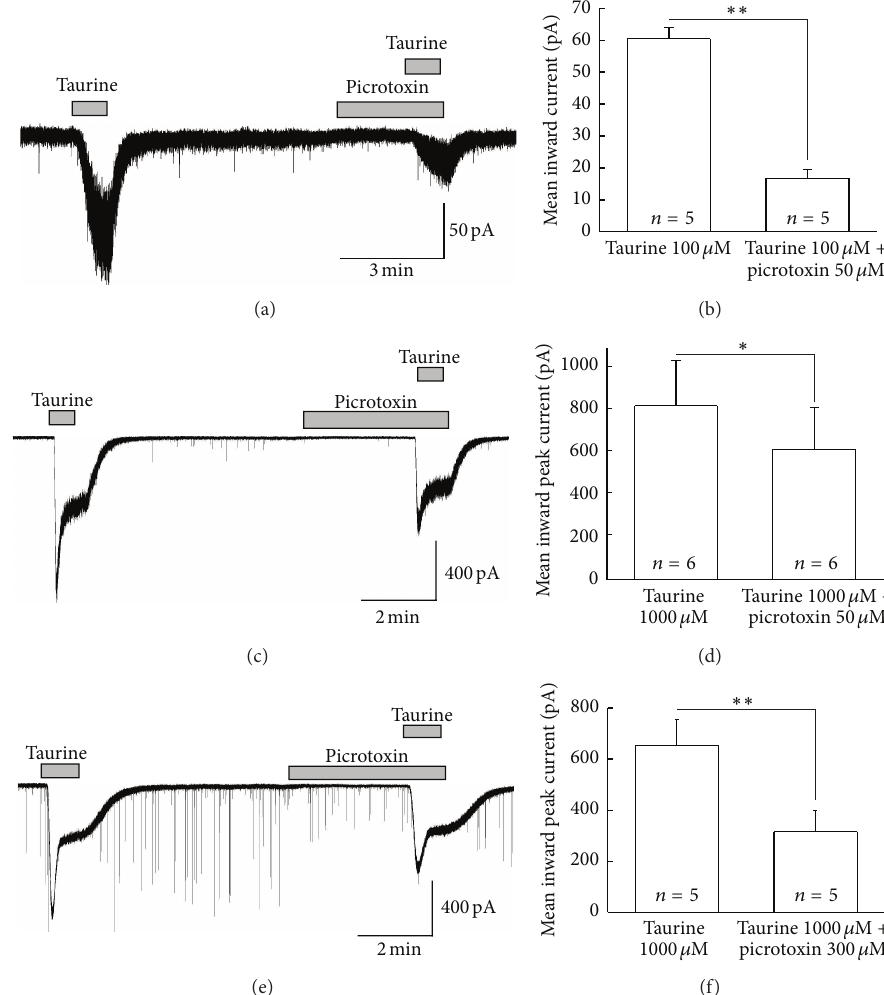
Figure 6: Taurine-induced inward current is sensitive to picrotoxin on SG neurons. (a), (c), (e) The representative traces showing currents evoked by 100 𝜇 M and 1,000 𝜇 M taurine were blocked by picrotoxin 50 𝜇 M and 300 𝜇 M. (b), (d), (f) Comparison of mean inward current changed by taurine alone with taurine in the presence of picrotoxin ( ∗ 𝑃 < 0.05 , ∗∗ 𝑃 < 0.01 ). Holding potential was − 60mV.